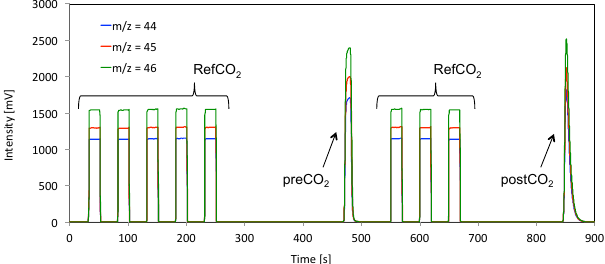
Figure 3. Example of a typical IRMS chromatogram. Eight square peaks of the working laboratory reference CO 2 (RefCO 2 ) are in- jected, and two CO 2 peaks of the measured air sample. Peak number 6 is non-equilibrated CO 2 (PreCO 2 ). Peak number 10 is isotopically equilibrated CO 2 (PostCO 2